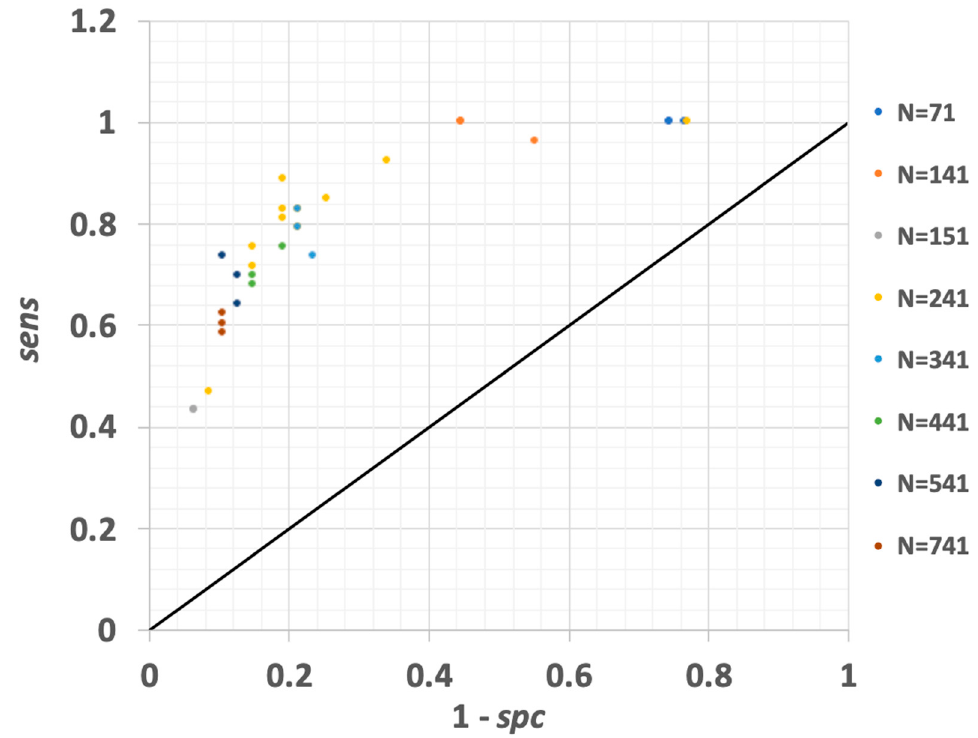
Figure 5. ROC curve for all gradient-boosted tree models explored. Models differ by adjusting parameters within RapidMiner. Here, N corresponds to number of trees. See text for remaining parameters adjusted. The gradient-boosted tree model performed the best of all models tested, achieving sens = 0.89, with spc = 0.81 and 85% of the scoring milk samples assigned to the correct diagnostic category for optimal model conditions. A project-maximum Youden index was achieved for this model when J = 0.7.